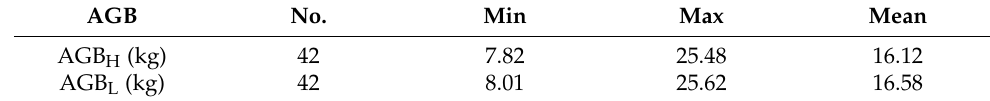
Table 3. Statistics of the estimated AGBs of individual Moso bamboos based on H and L, respectively.